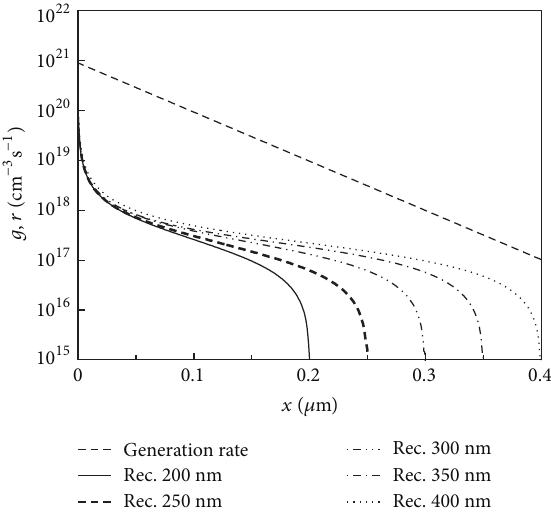
Figure 4: Simulated carrier generation rate and recombination rate as a function of the i-layer